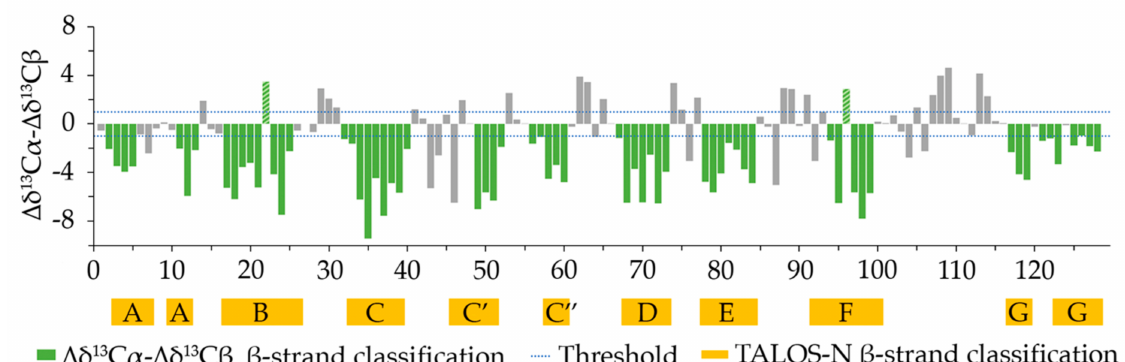
Figure 3. The chemical shift indexing analysis (CSI), computed by taking the difference between the experimentally deter- mined C α chemical shifts and the C α random coil chemical shift ( ∆ δ 13 C α ) minus the difference between the experimentally determined C β chemical shift and the C β random coil chemical shift ( ∆ δ 13 C β ). Three negative ∆ δ 13 C α − ∆ δ 13 C β values in a row indicate the presence of β -strand. A cumulative threshold error based on the individual ∆ δ deviations of ± 0.7 ppm, (cid:112) ( 0.7 2 + 0.7 2 ) ∼ = 1 ppm, was used as a threshold to include only significantly varying consecutive negative values. i.e., Residues predicted to be in β − strands are highlighted in green in the graph. The chemical shift differences of Cys22 and Cys96 (highlighted by green hatched bars) deviate because of upfield shifts induced by aromatic sidechains. As a consequence, especially for the C β chemical shifts, typical values of the reduced cysteines were observed despite the presence of the disulfide bridge with the associated β structure content. Control CD spectra of oxidized and reduced Nb23 are reported in Supplementary Materials to illustrate the issue, showing that Cys22 and Cys96 form a disulfide bridge. Yellow blocks indicate the position of residues that were estimated to be in β − strands by